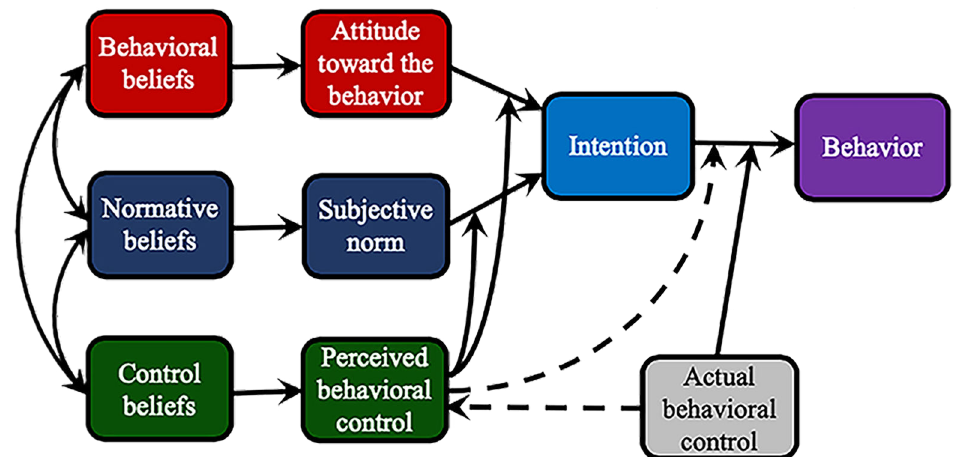
Figure 2. Graphical depiction of the theory of planned behavior (Ajzen,